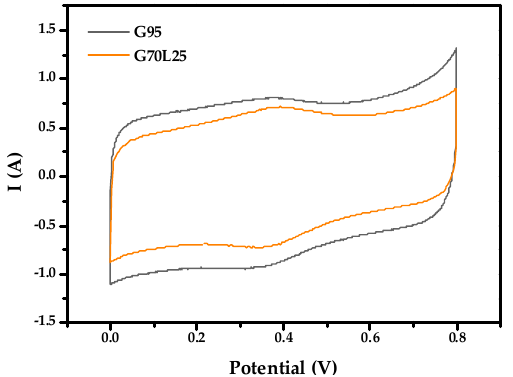
Figure 5. Cyclic voltammetry at 5 mV/s of G95 electrode and G70L25 electrode in 1 M H 2 SO 4.